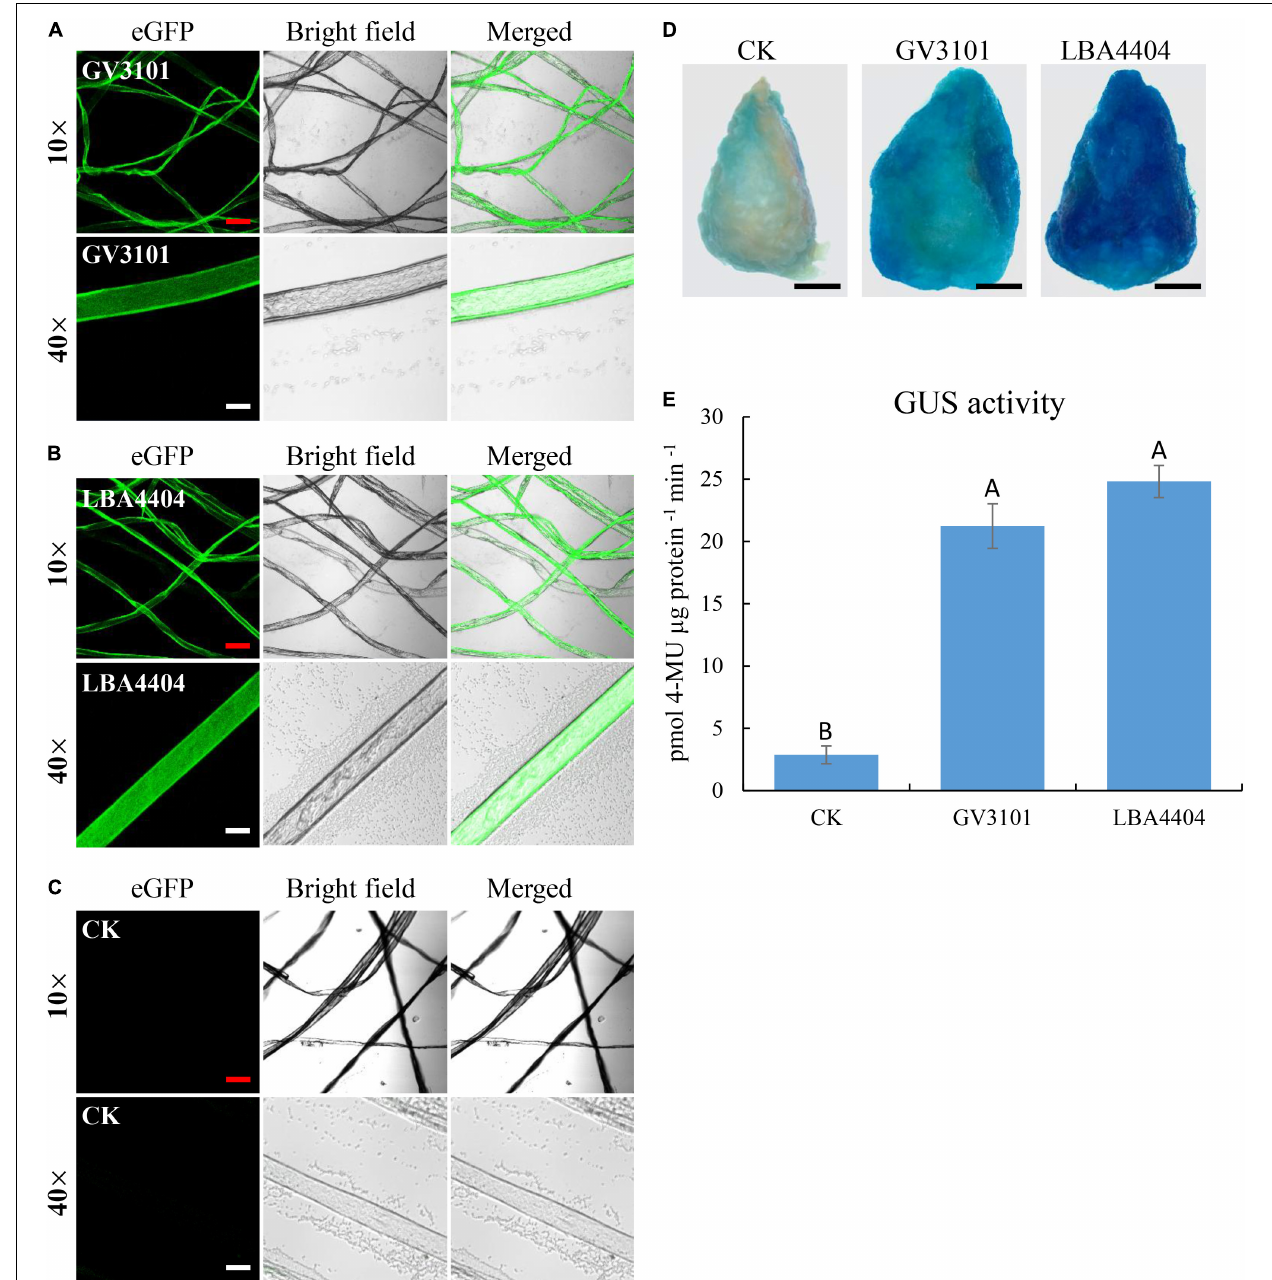
FIGURE 2 | Transient expression of enhanced green fluorescence protein (GFP) gene (eGFP) and β -glucuronidase (GUS) protein in cotton fibers incubated with different Agrobacterium strains. (A,B) eGFP signal observation in cotton fibers transiently expressing 35S::eGFP construct using GV3101 (A) or LBA4404 (B) . (C) Fibers without Agrobacterium infection were used as control. The red line and white line indicate 100 and 25 µ m, respectively. (D,E) GUS staining (D) and activity determination (E) of cotton fibers transiently expressing 35S::GUS construct using GV3101, LBA4404, or fibers without Agrobacterium infection. Fibers on one seed were used as one biological replicate, and at least, three independent biological replicates were detected. The black line indicates 2 mm. Different upper case letters in (E) indicate significant differences at P < 0.01 (Turkey’s test). Error bars indicate the SD of three biological replicates. Fibers at 20-day post-anthesis (DPA) were used for